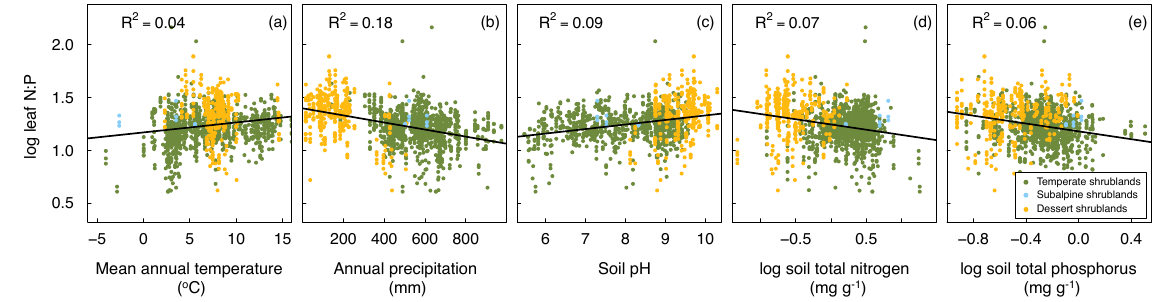
Figure 3. Changes of log-transformed leaf N:P ratios in relation to climate (mean annual temperature and annual precipitation) and soil nutrition (soil pH and soil total nitrogen and phosphorus concentrations) for shrubs in northern China. Green, yellow, and blue dots represent samples from temperate, subalpine, and desert shrublands, respectively. Solid lines represent regressions significant at p< 0 . 001. Table 2. Summary of main-effect general linear models for leaf N and P concentrations and N:P ratios of shrubs in northern